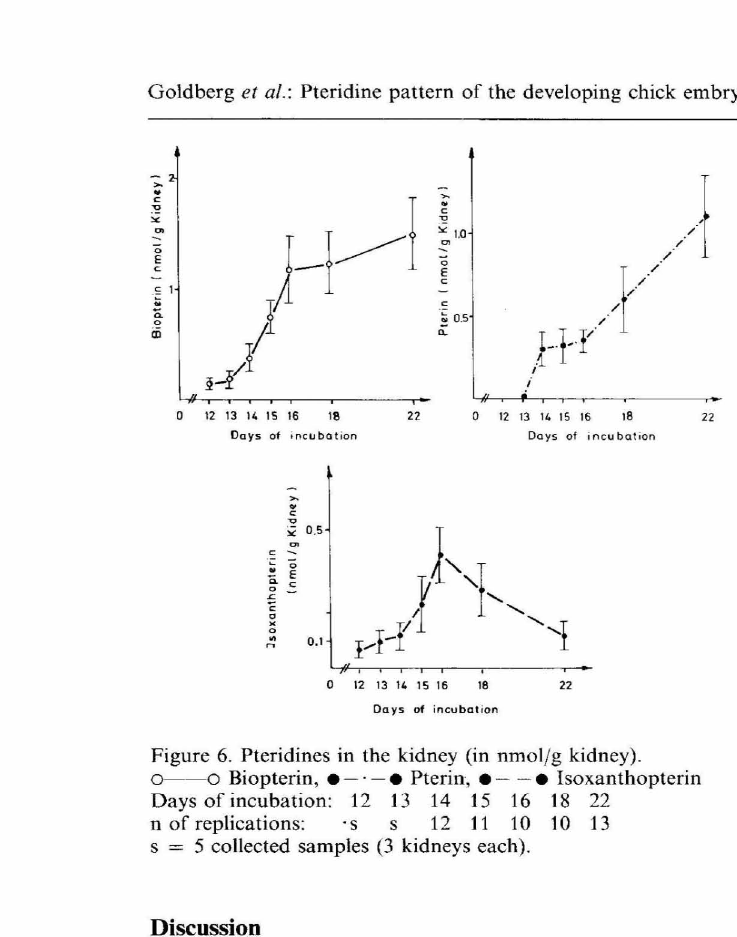
Figure 6. Pteridines in the kidney (in nmol/g kidney). 0 --0 Biopterin, • - . -. Pterin, • - -. Isoxanthopterin Days of incubation: 12 13 14 15 16 18 22 n of replications: 's s 12 11 10 10 13 s = 5 collected samples (3 kidneys